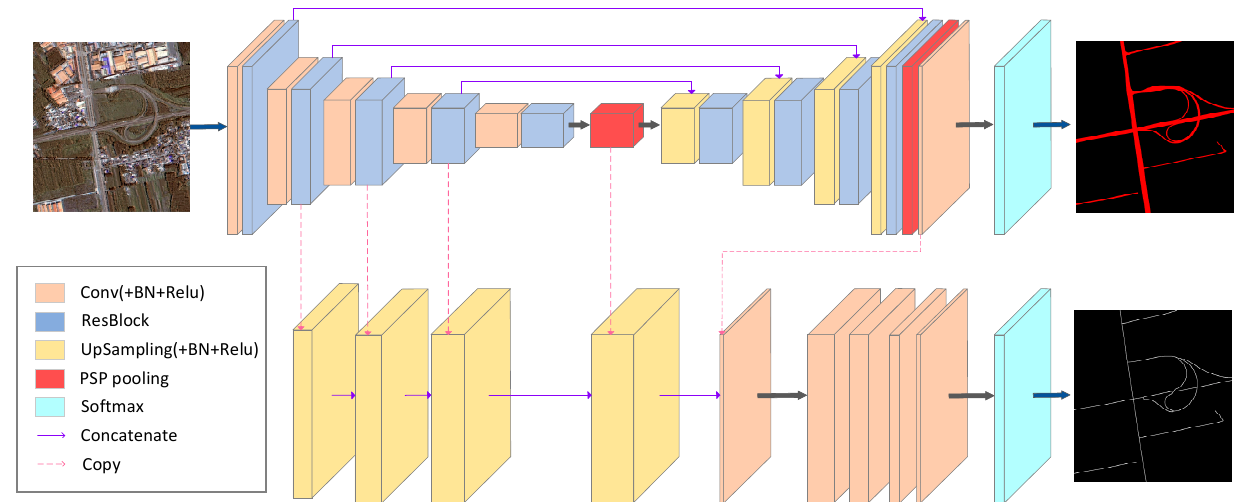
Figure 5. Flowchart of MRENet, which contains two joint convolutional neural networks: road surface extraction network and road centerline extraction network.